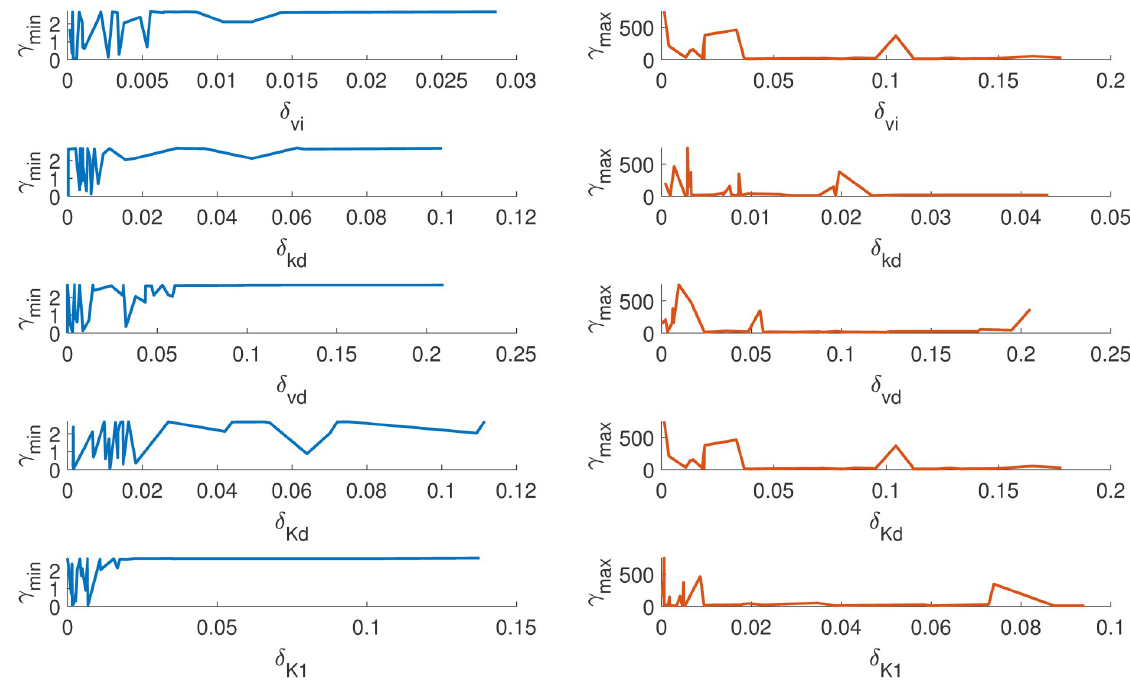
Fig 7. γ min and γ max changes with respect to the absolute change in each parameter v i , k d , v d , K d , K 1 from reference values. The parameters K 1 and v d are highly insensitive within the given δ